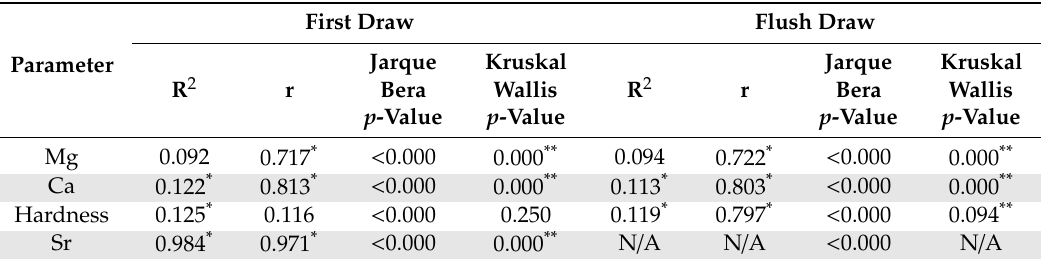
Table 2. Statistical analysis of water quality parameter relationships to strontium.